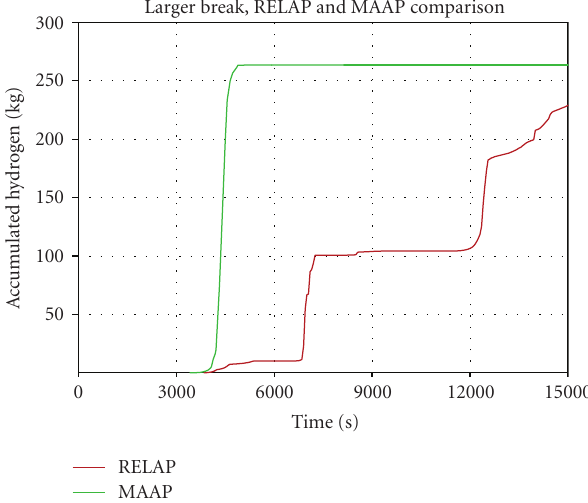
Figure 18: Mass of accumulated hydrogen, Group 2.